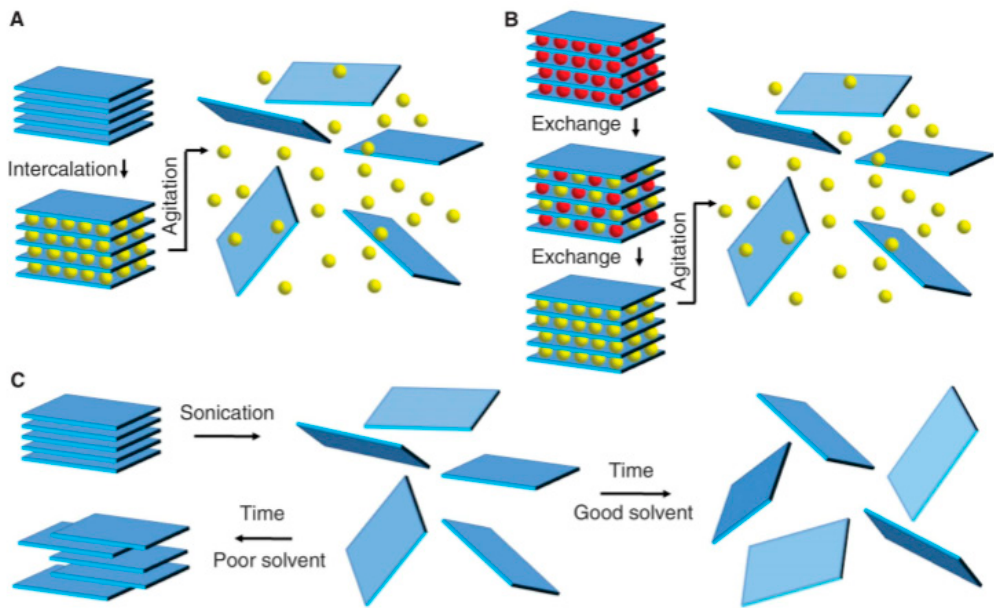
Figure 5. Schematic description of the main liquid exfoliation mechanisms: ( a ) ion intercalation; ( b ) ion exchange; ( c ) sonication-assisted exfoliation. Reproduced with permission from Ref. [97]. Copyright AAAS, 2013.